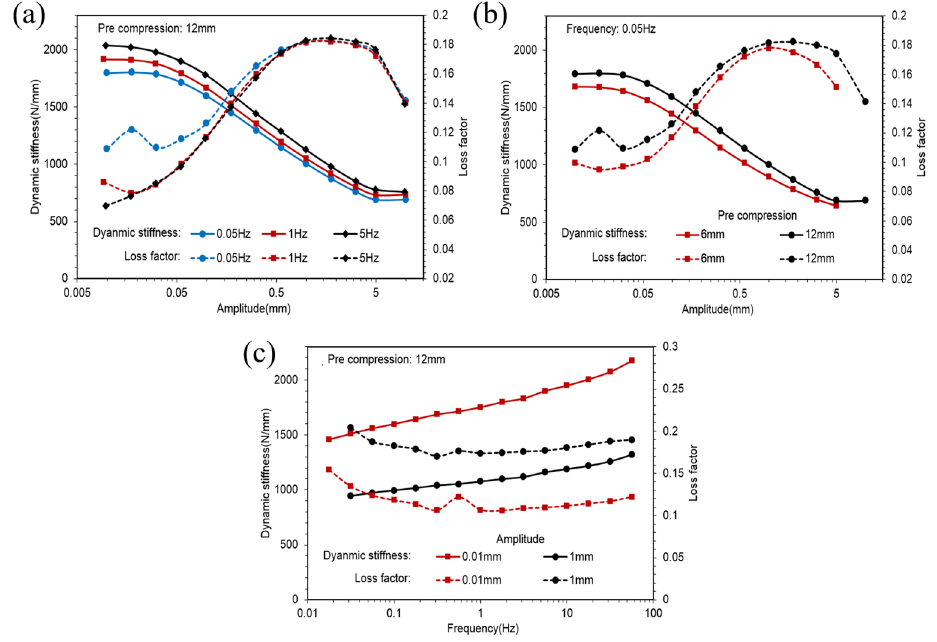
Figure 8. Dynamic stiffness and loss factors curves of the SCCT rubber spring. Figure 9a,b show the hysteresis loops of different amplitudes of the SCCT rubber spring in 0.05 Hz with 12 mm pre-compression. Figure 9c illustrates the hysteresis loops of different frequencies in 1 mm amplitude with 12 mm pre-compression.